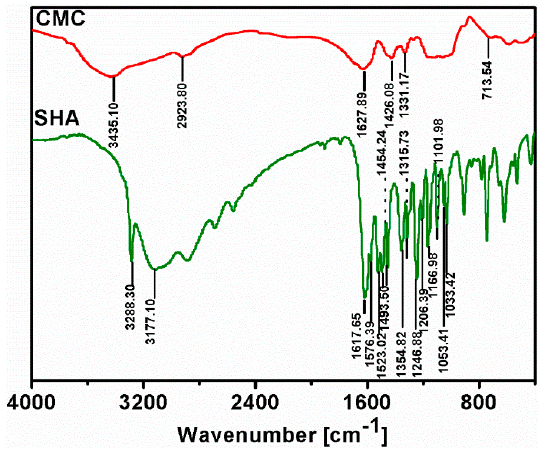
Figure 7. FTIR spectra of CMC and SHA.